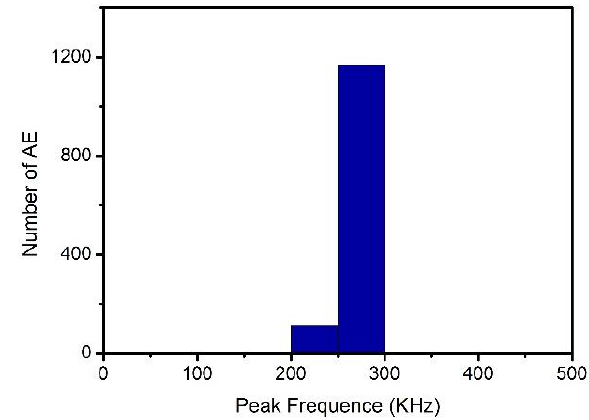
Figure 12: FFT peak frequency distribution of fiber bundle